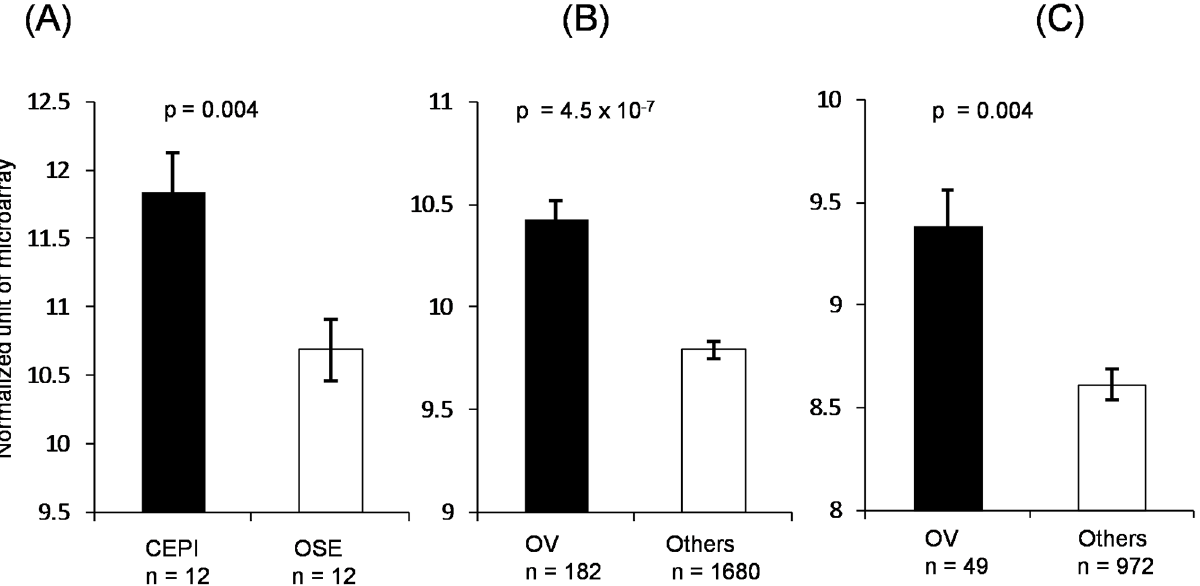
Fig 5. Significantly high expression of BAIAP2L1 in ovarian cancer tissues and ovarian cancer cell lines. (A) The mRNA expression levels of BAIAP2L1 in ovarian cancer epithelial cells (CEPI) isolated from12 ovarian serous adenocarcinoma and ovarian surface epithelium (OSE) from 12 normal human ovaries. Data are retrieved from GSE14407. (B) The expression levels of BAIAP2L1 in tissues of ovarian cancer (OV, n = 182) and cancer of other primary sites (n = 1680). Data are retrieved from GSE36133. (C) The expression levels of BAIAP2L1 in cell lines of ovarian cancer (OV, n = 49) and other origins (n = 972). Data are retrieved from